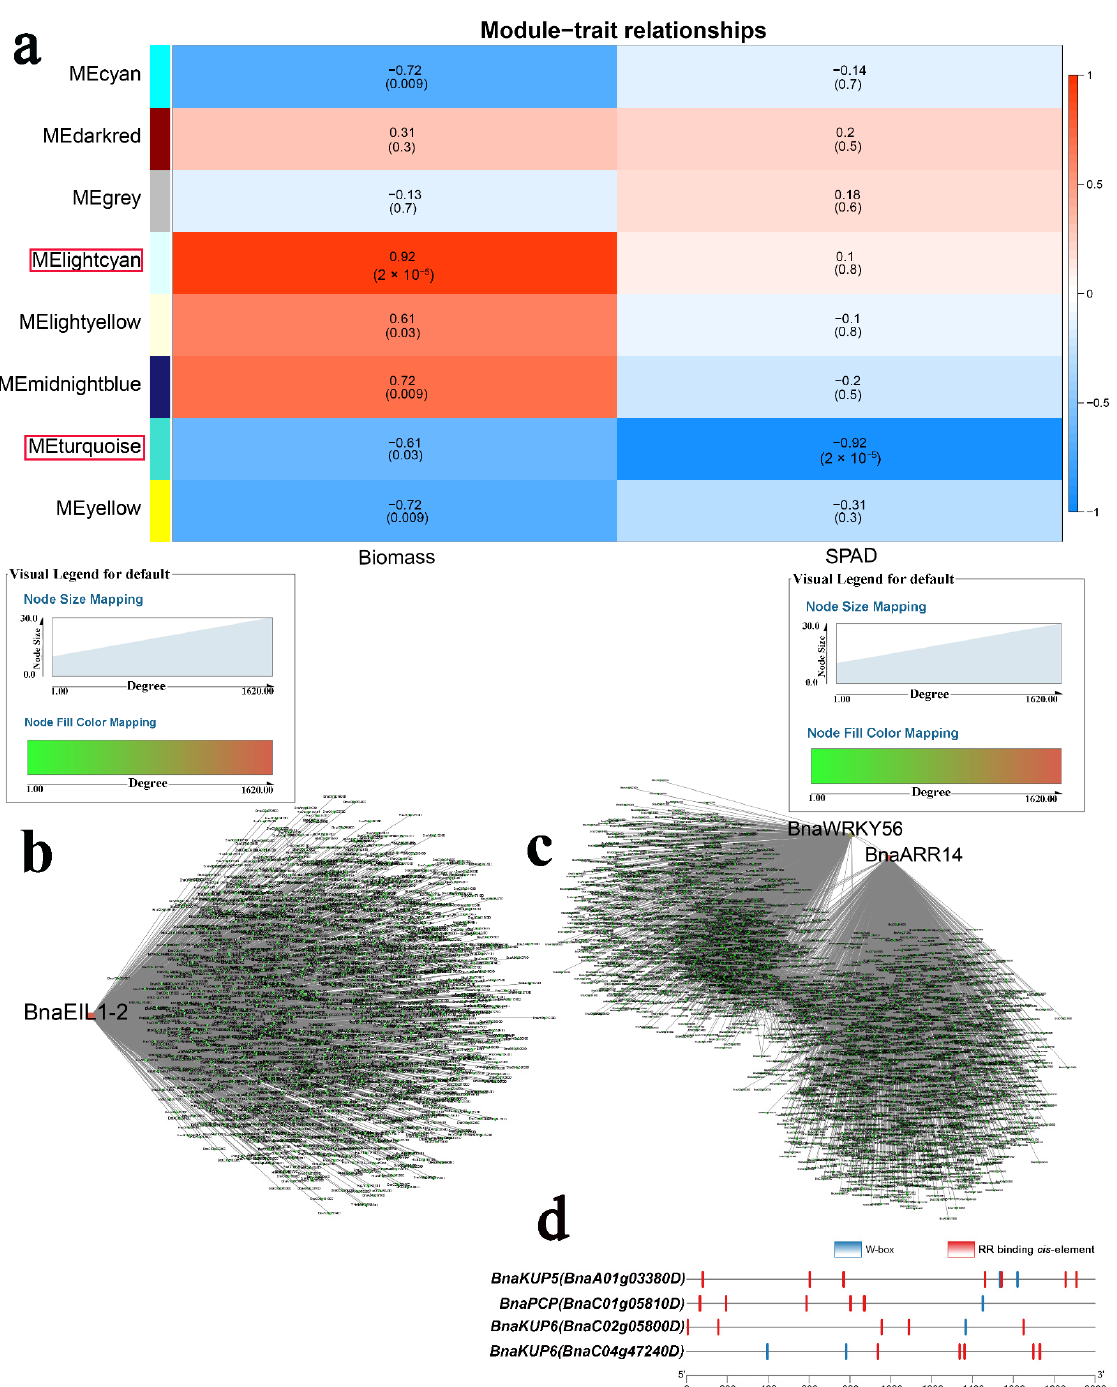
Figure 6. WGCNA of rapeseed genes in response to K starvation. ( a ) Module-trait correlation showing the significance of module eigengene correlation with traits (biomass and SPAD). Left panel shows modules. ( b ) Cytoscape representation of the relationship of hormone-related TFs in “lightcyan” module. Key genes are represented by large red circles. ( c ) Cytoscape representation of the relationship of hormone-related TFs in “turquoise” module. Key genes are represented by large red circles. ( d ) W-box and RR binding cis -element in promoters of BnaKUP5 , BnaPCP , and BnaKUP6